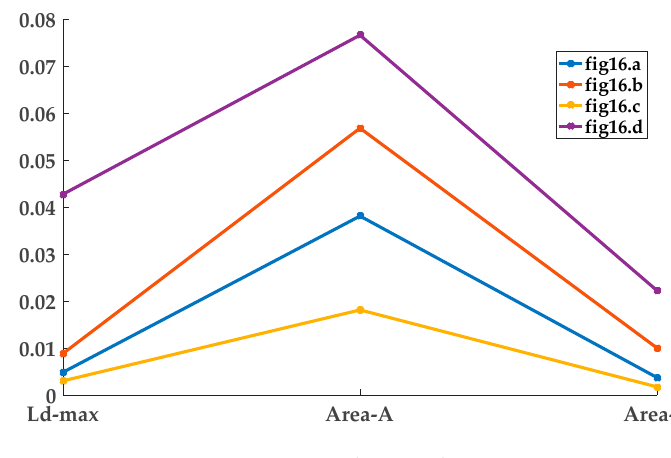
Figure 17. Evaluation chart.